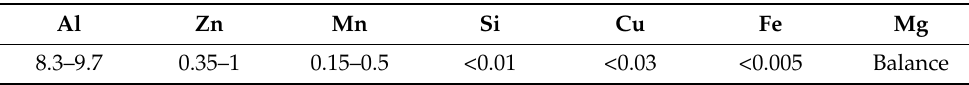
Table 1. Chemical composition of the base metal